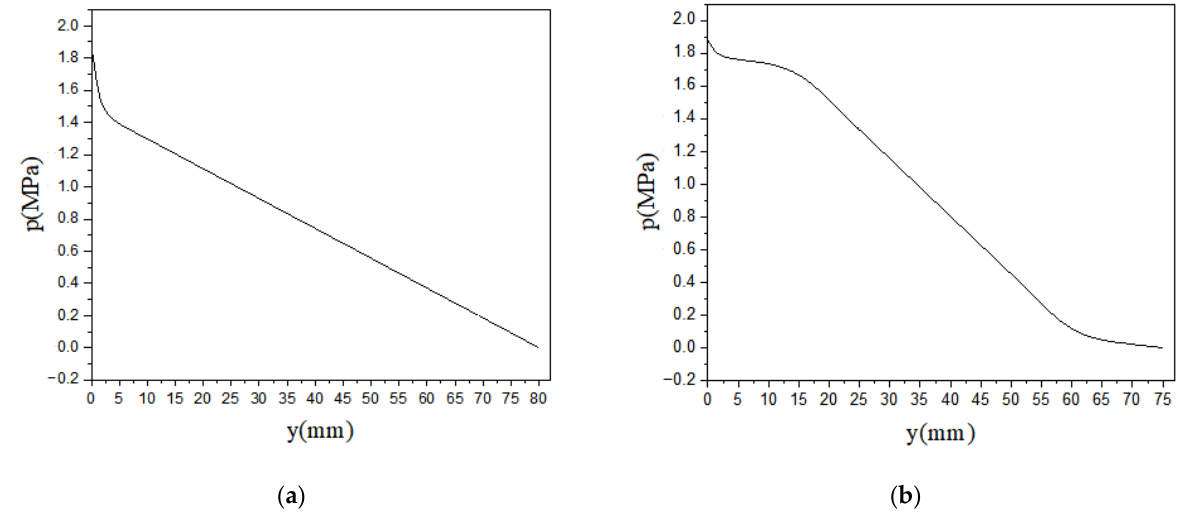
Figure 13. Pressure drop along x = 5mm ( a ) for rectangular and ( b ) dog bone samples.